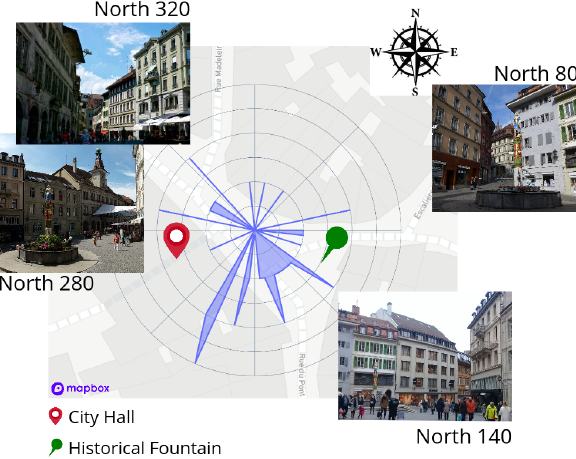
Figure 5: Visualization of the photographs taken on Palud square, Lausanne represented on a polar graph. The polar graph represents the volume of photos taken every 6°. The values range from 0 to 3 photographs. The map of the square is present in the background. Four photos illustrating specific orientations are also Figure 4: Visualization of photographs’ shooting orientation depicted on a polar graph. Each graph represents one of the four seasons.